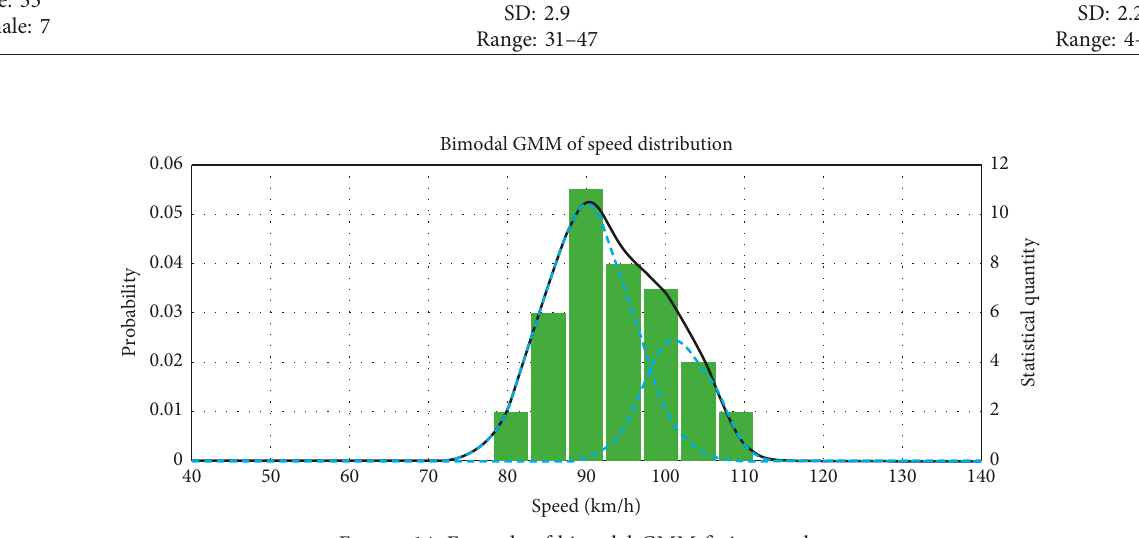
Figure 14: Example of bimodal GMM fitting result. Table 2: Parameters in the bimodal GMM fitting example.